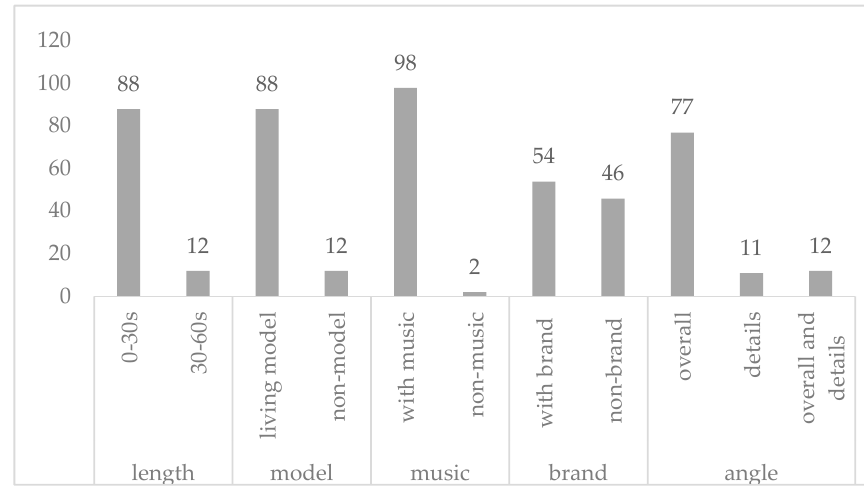
Figure 1. The main characteristics of the short video displays.